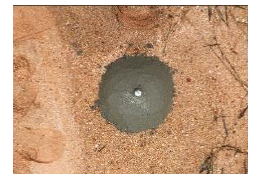
Figure 13. The example of control points established